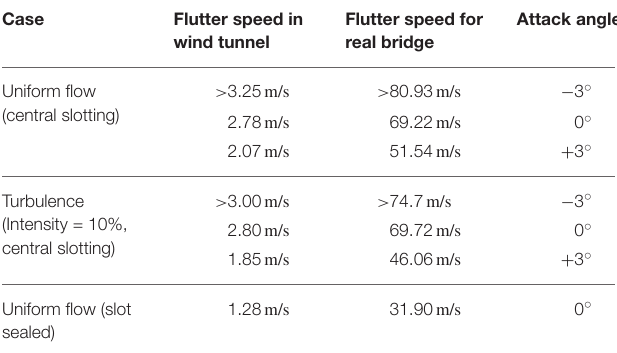
TABLE 6 | Critical flutter wind speed (with central buckle).